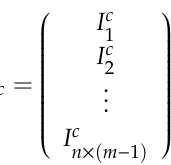
Figure 14. The eight ‐ neighborhood traversal.